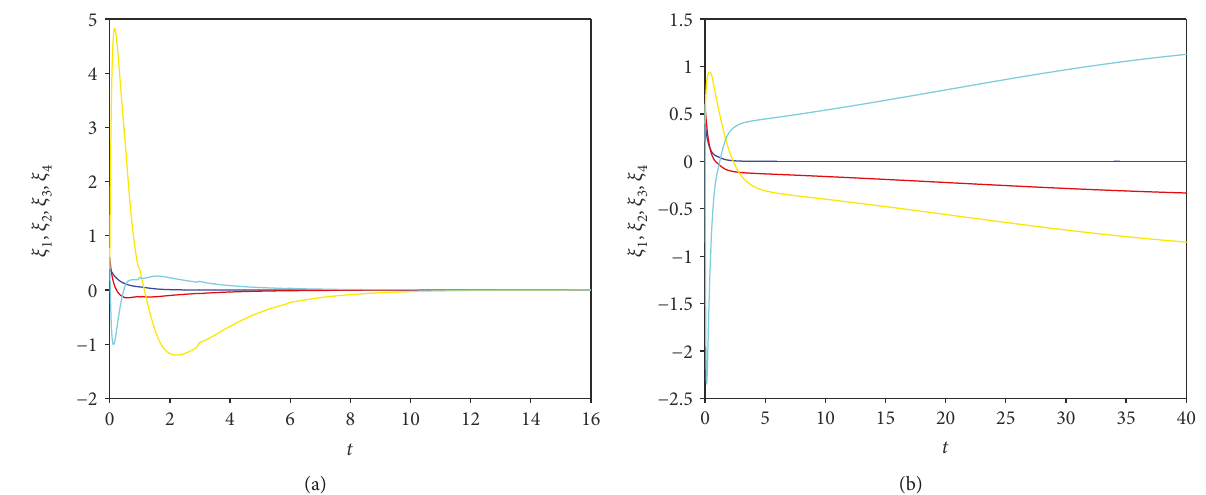
Figure 3: (a) State trajectories of error system (7) with controller (5). (b) State trajectories of error system (7) without controller